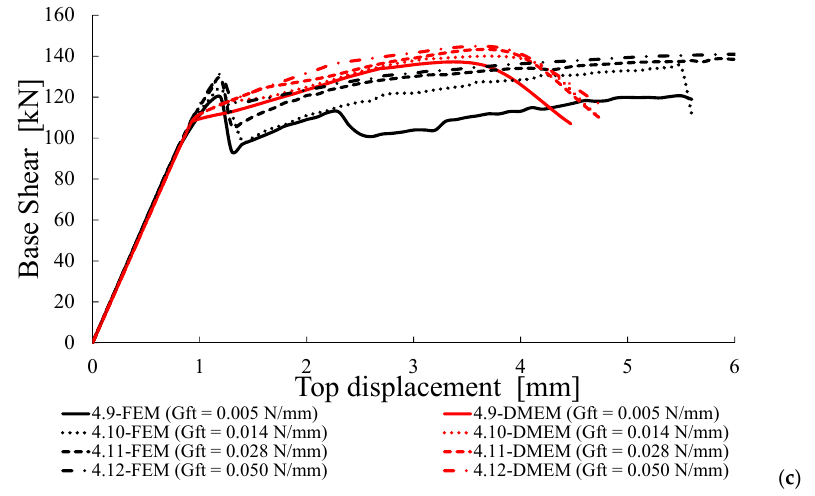
Figure 14. Capacity curves for Group D: ( a ) σ 0 = 0.3 MPa and f c = 3.0 MPa, ( b ) σ 0 = 0.3 MPa and f c = 4.5 MPa, ( c ) σ 0 = 0.6 MPa and f c = 4.5 MPa.